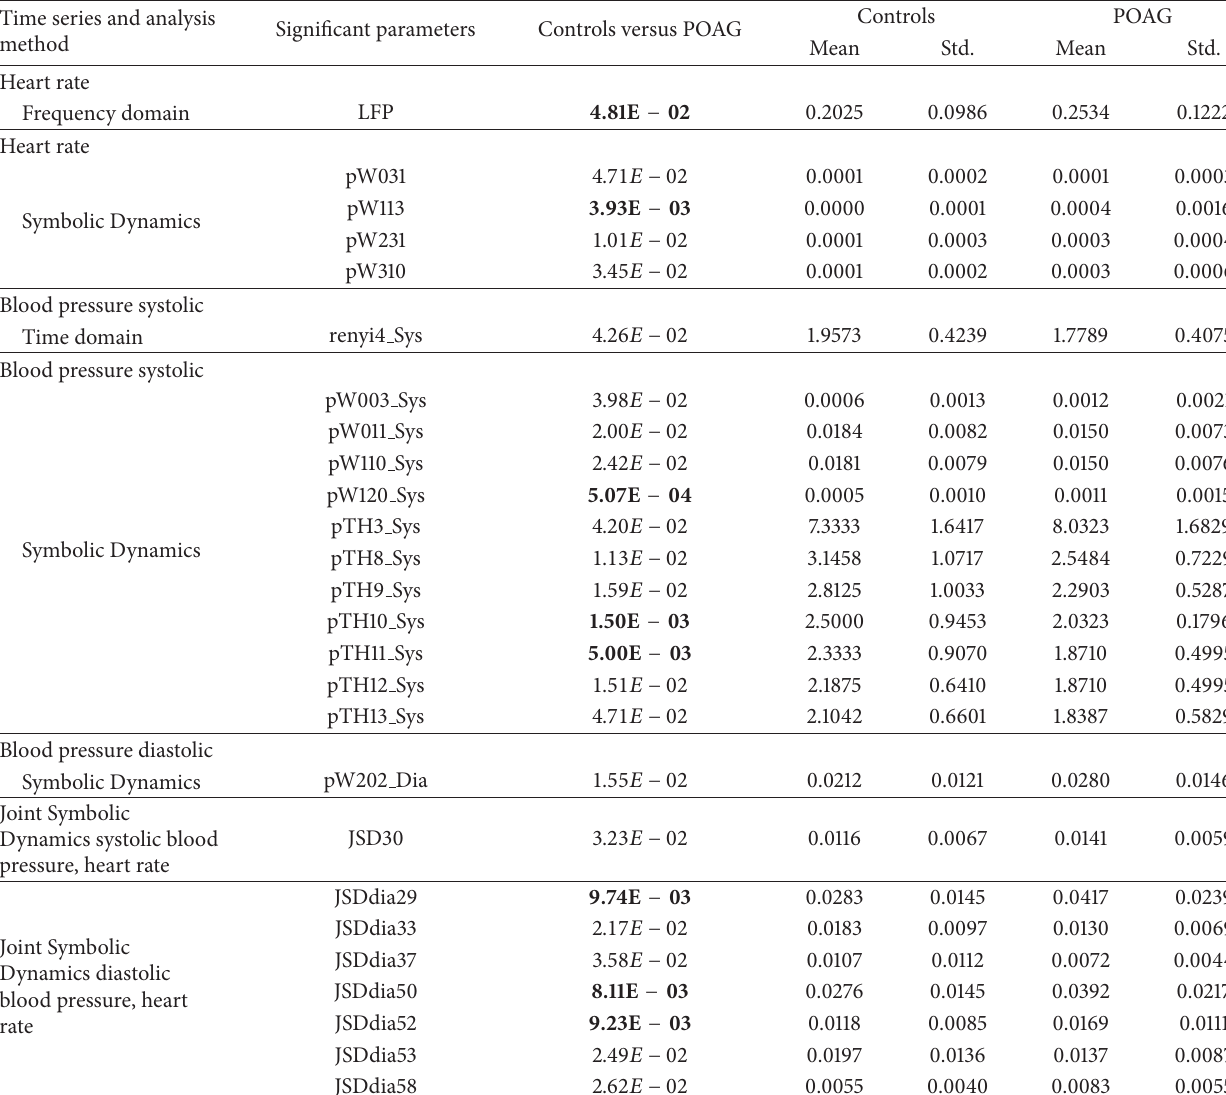
Table 5: Significant parameters ( 𝑝 value, mean value, and standard deviation) separating controls versus patients with POAG according to time series and analysis